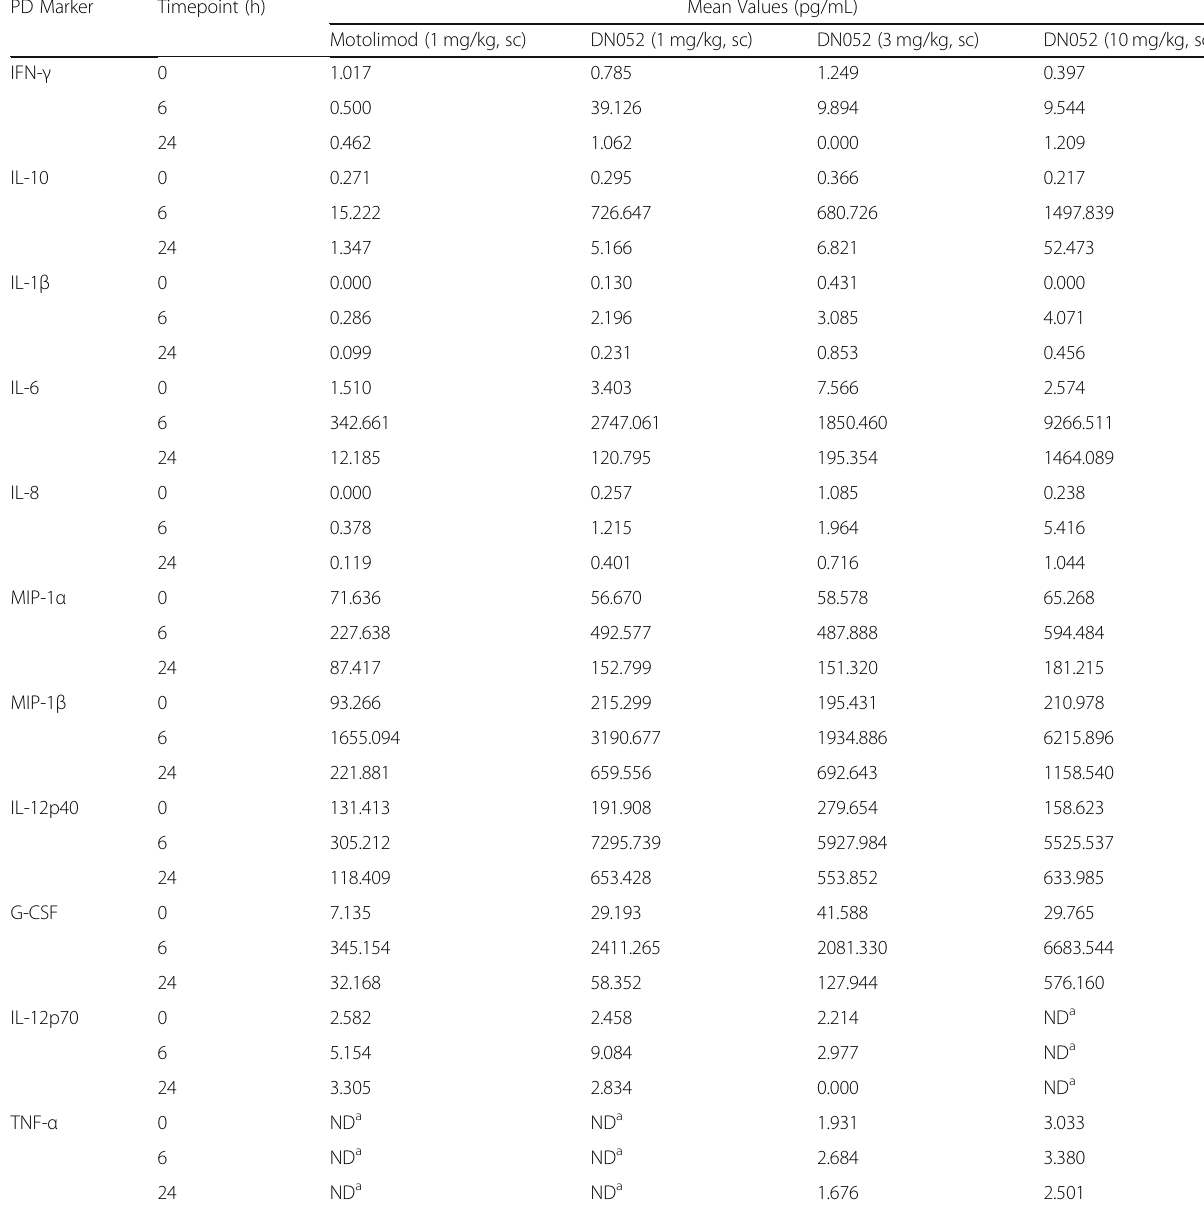
Table 4 DN052 induced cytokines in monkeys PD Marker Timepoint